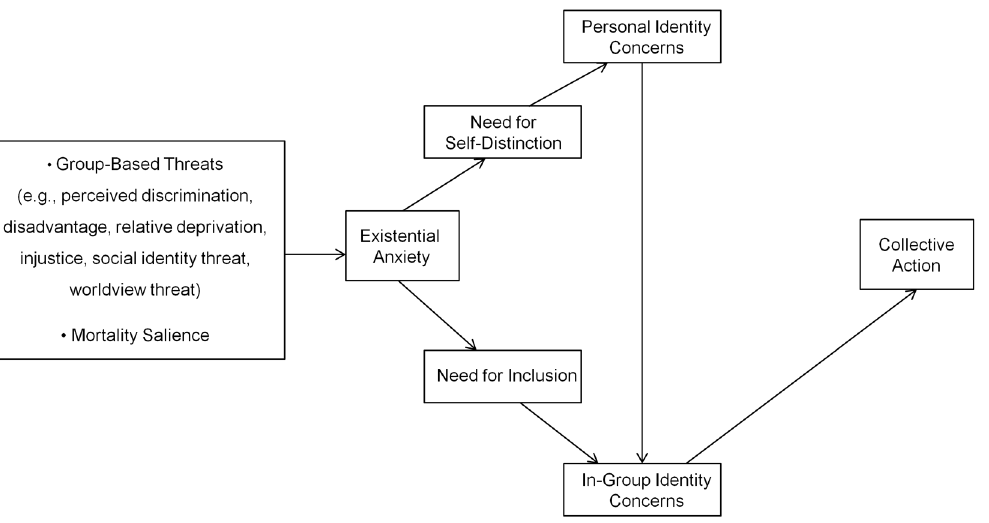
Figure 1. Integrative model of collective